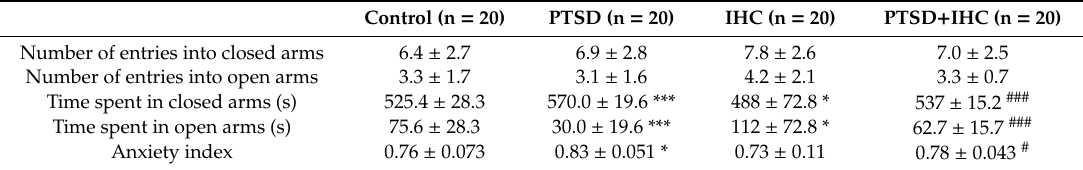
Table 1. E ff ects of experimental posttraumatic stress disorder (PTSD), intermittent hypoxic conditioning (IHC), and their combination on behavioral indexes in elevated